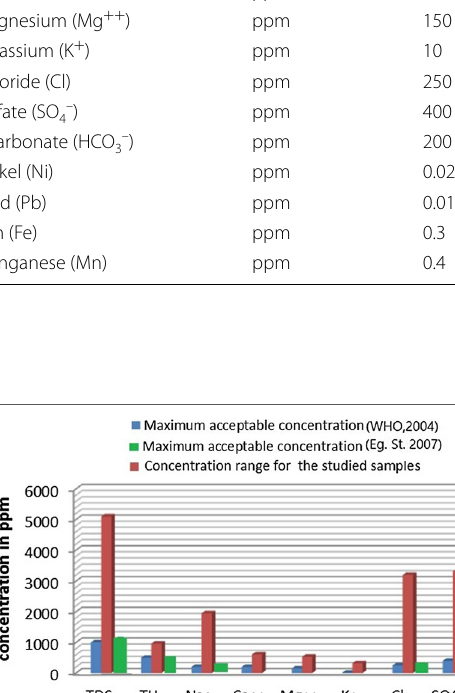
Fig. 11 Ion concentrations in the available groundwater samples and their relations with the WHO